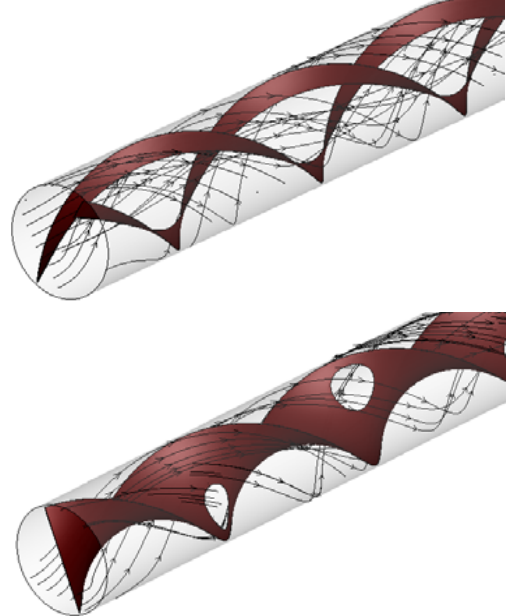
Fig. 10. Streamlines for the two types Fig .10. Streamlines for the two types tapes Fig .10. Streamlines for the two types tapes